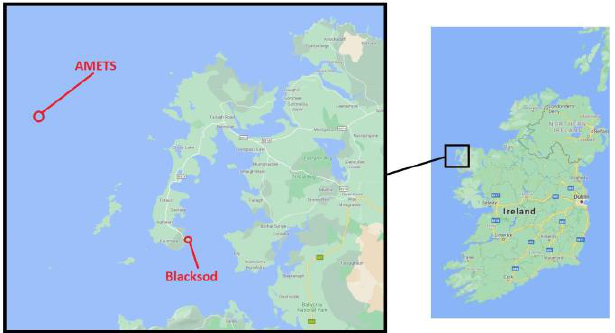
Fig. 5. Locations of Blacksod port and offshore wave farm at AMETS.